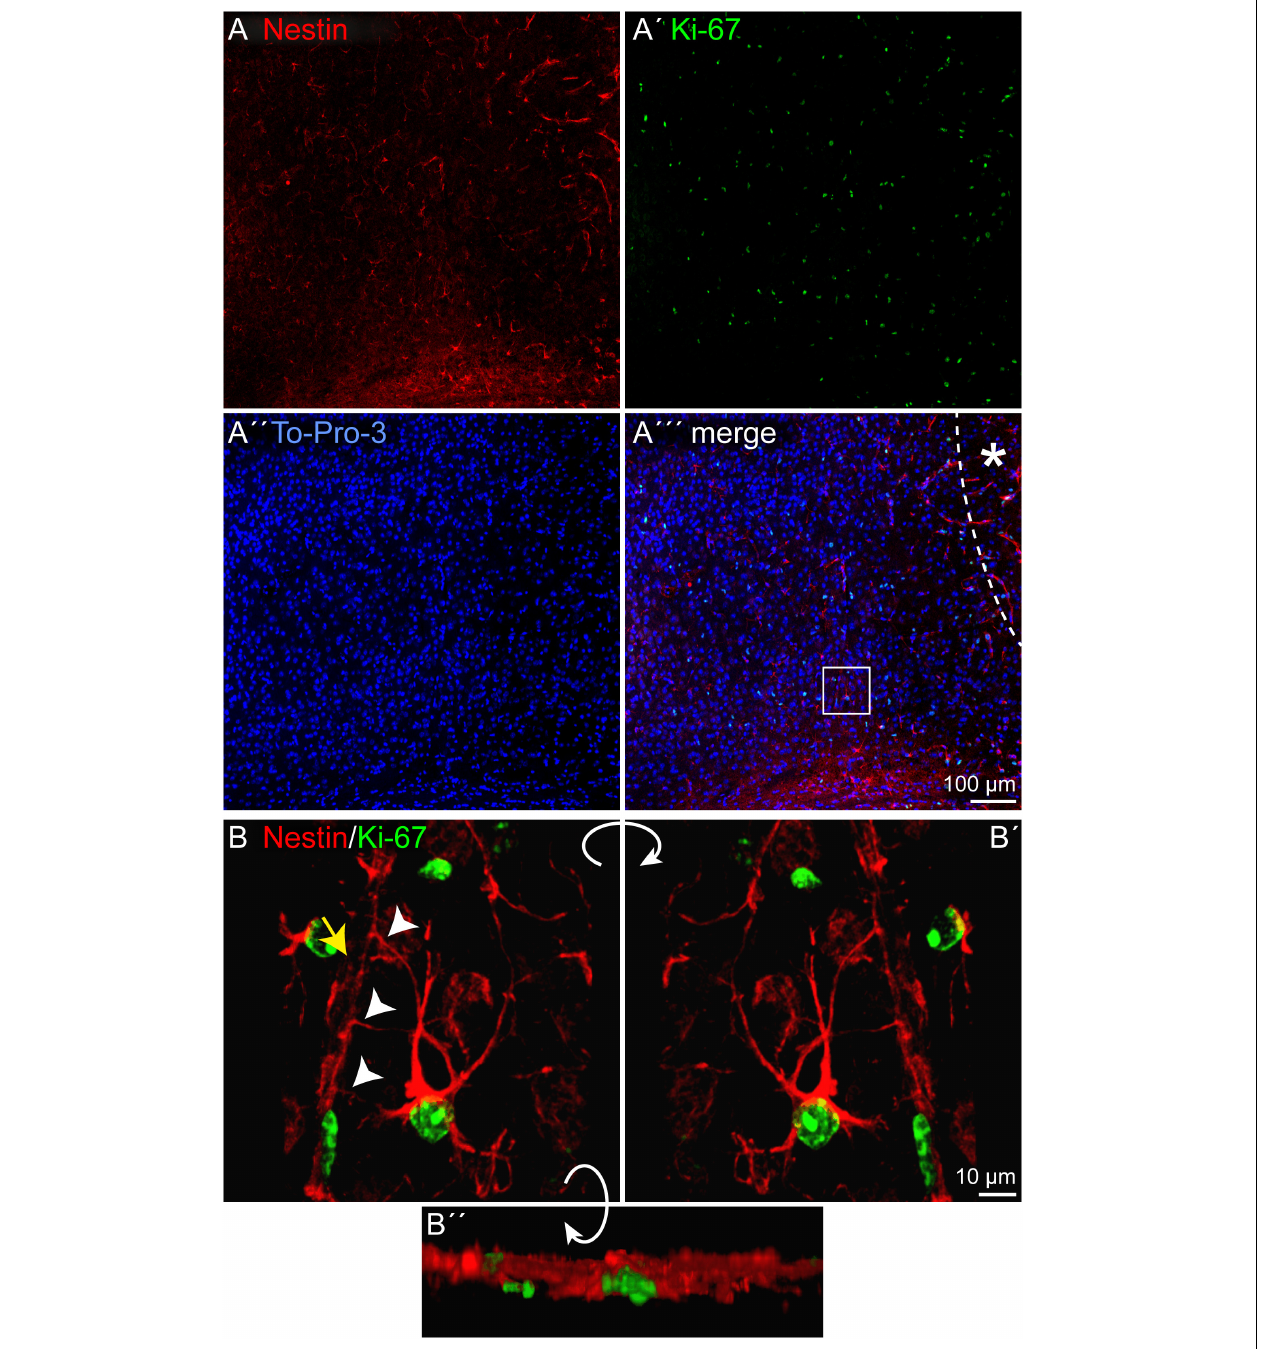
FIGURE 4 | Proliferation of nestin-positive cells, 3 dpl. (A–A (cid:48)(cid:48)(cid:48) ) Staining of the proliferation marker Ki-67 revealed numerous proliferating cells in the penumbra after lesion. Some of these cells were also nestin-positive. (B–B (cid:48)(cid:48) ) An example of such a cell boxed in (A (cid:48)(cid:48)(cid:48) ) is shown after three-dimensional reconstruction of confocal images. The cell formed at least three contacts (arrowheads) to vasculature (yellow arrow). Asterisk: direction toward the lesion core; scale bars: 100 µ m (A–A (cid:48)(cid:48)(cid:48) ) , 10 µ m (B–B (cid:48)(cid:48) ) .